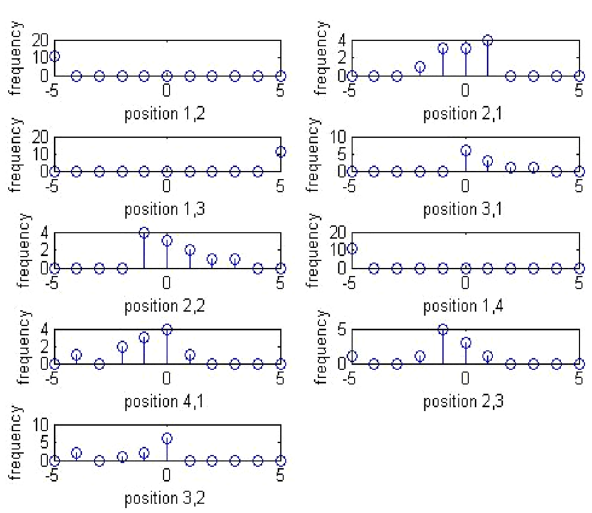
Figure 8. Dual histogram of sample stego